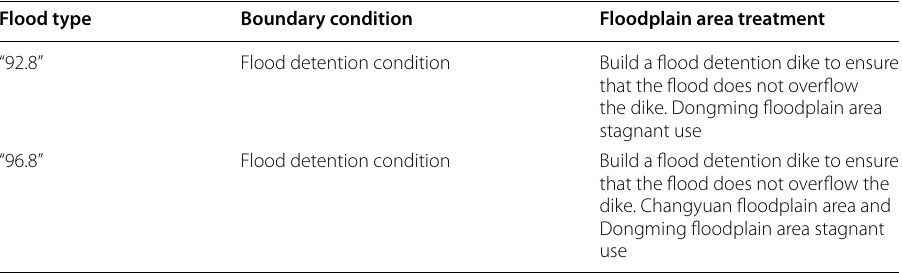
Table 2 Calculation conditions and boundary conditions Flood type Boundary condition Floodplain area treatment